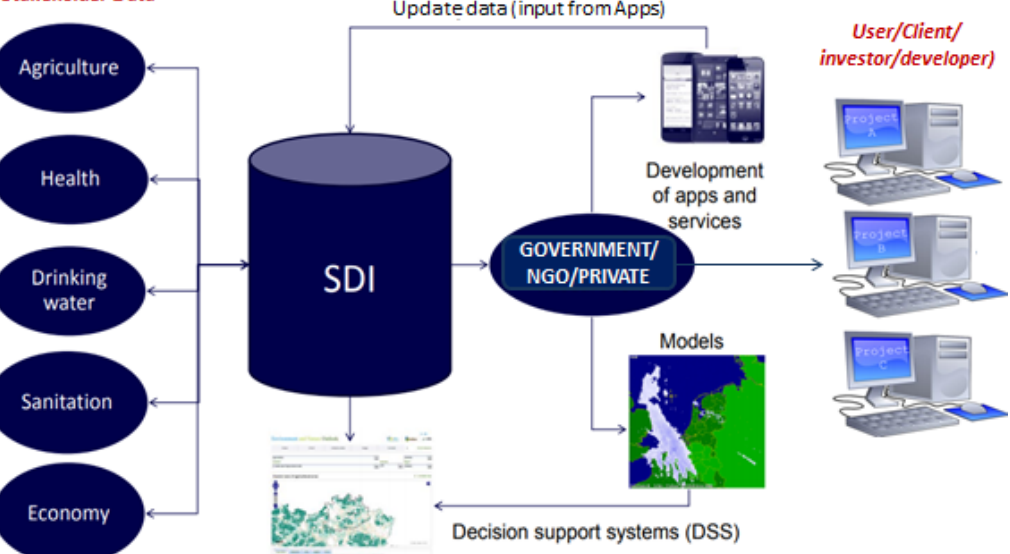
Figure 15: Example of a general integrated/collaborative architecture sharing design.